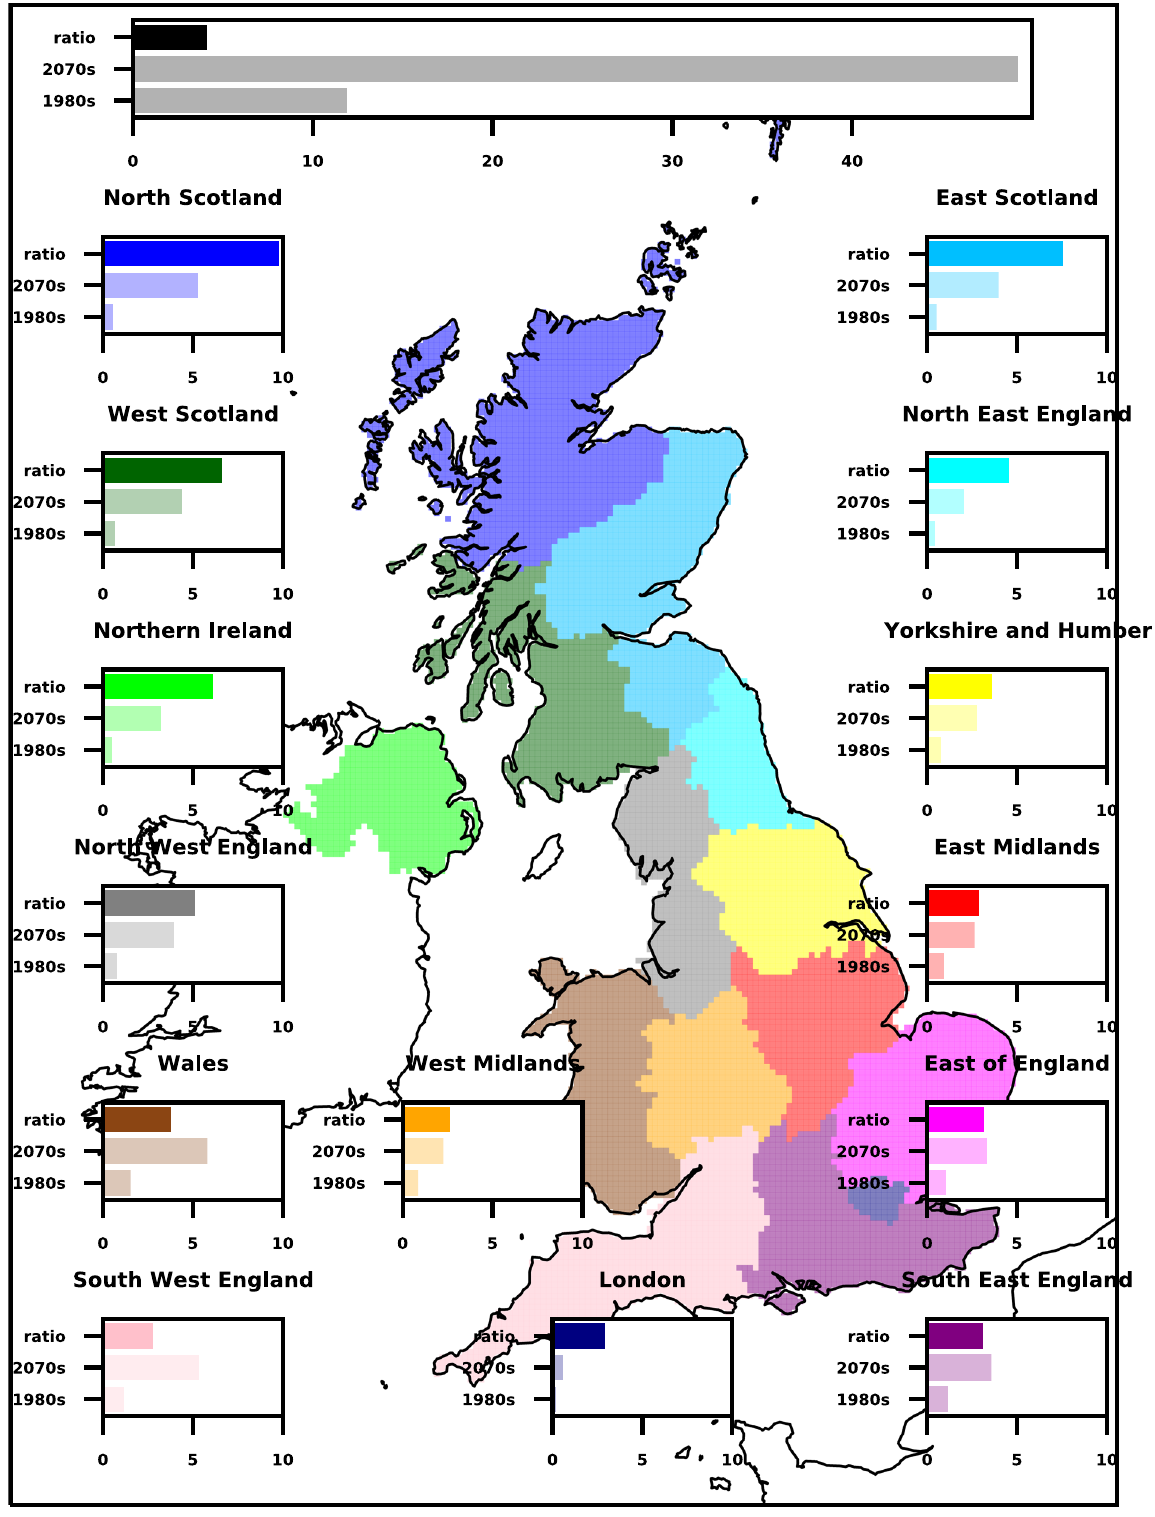
Fig. 4 | Future changes in the occurrence of extreme hourly precipitation regionally. Average number of events per year exceeding 20mm/h in the 1980s and 2070s, and their ratio (future/control), for regions of the UK. Values corre- spond to the multi-member 10-year mean number of events, for hourly rainfall